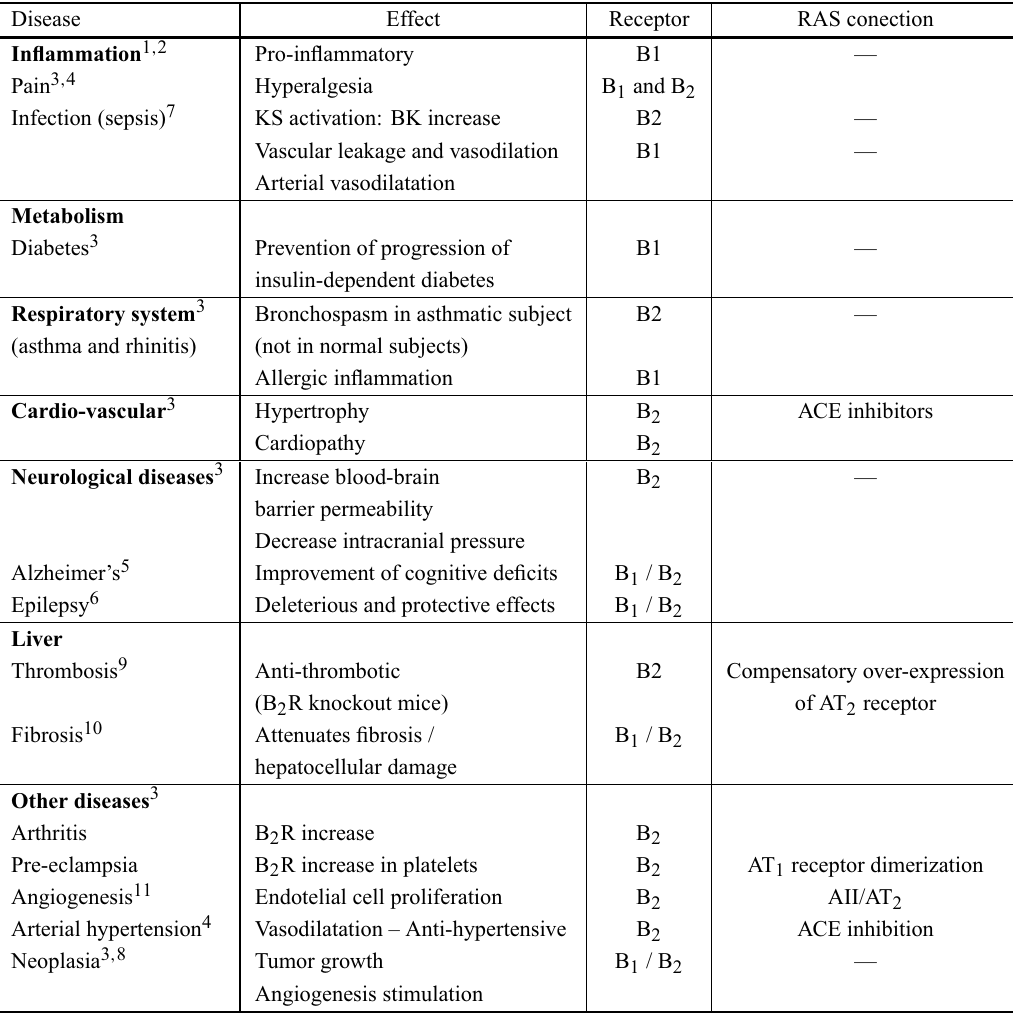
Bradykinin receptors and some pathophysiological